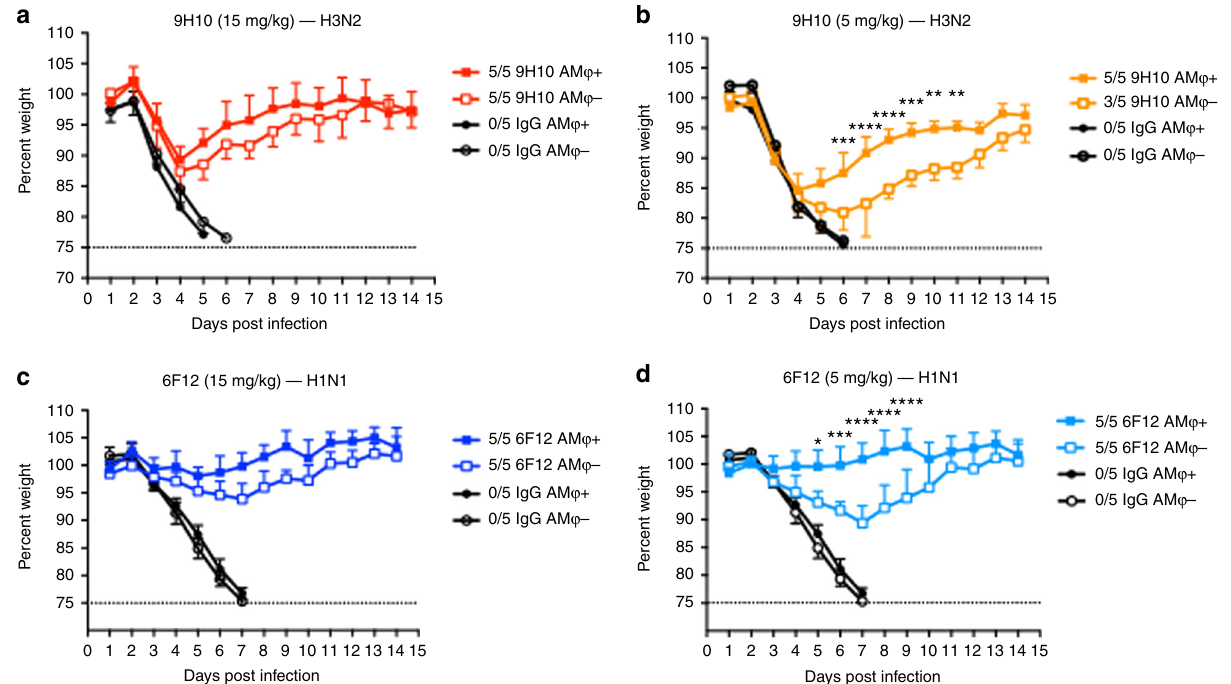
Fig. 6 AM φ play an important role in mediating in vivo protection by bNAb. BALB/c mice were treated IN with clodronate liposome to deplete AM φ . Control mice received PBS liposome. Mice were either treated with ( a ) 15 mg per kg or ( b ) 5 mg per kg of 9H10 IP, and were challenged IN with 5 mLD 50 of X31. Another set of mice received ( c ) 15 mg per kg or ( d ) 5 mg per kg of 6F12, and then challenged with 5 mLD 50 of NL09. Of note, the ( a ) 15 mg per kg data set is identical to the AM φ + group in Fig. 3a. A mAb against GST was used as an IgG control. The ratios in the fi gure legends indicate the number of animals that survived challenge over total number of animals per group. Two-way ANOVA and Sidak ’ s multiple comparisons tests were used to determine statistical signi fi cance (GraphPad Prism). For all panels: * P ≤ 0.05, ** P ≤ 0.01, *** P ≤ 0.001; NS, not signi fi